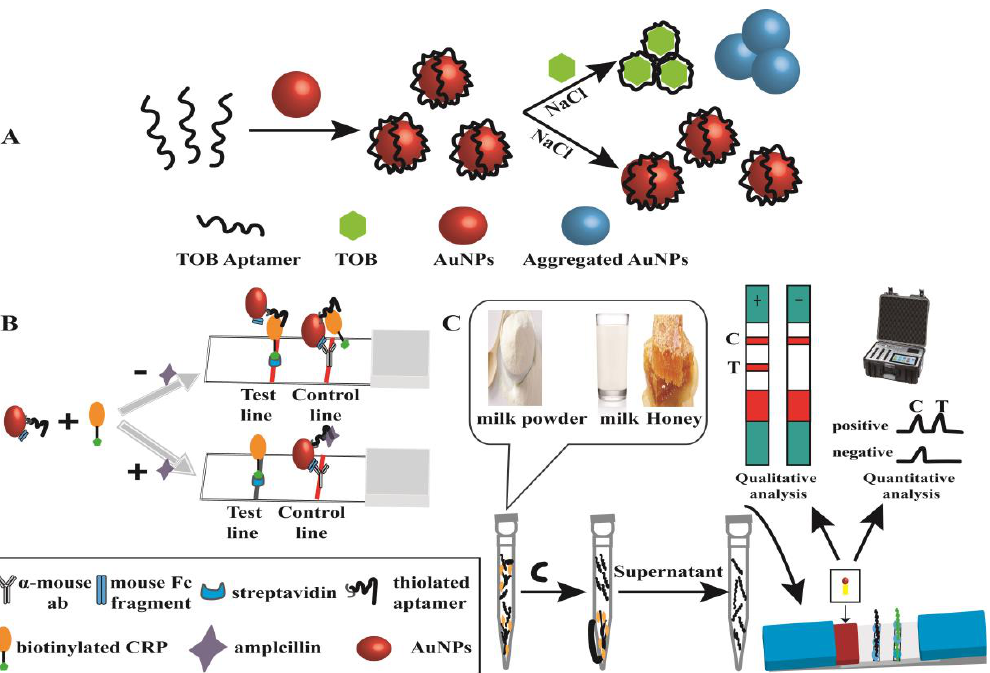
Figure 7. Nanomaterial-based colorimetric methods for antibiotic analysis. ( A ) The determination of tobramycin based on unmodified AuNPs, a single-strand DNA (ssDNA) probe, and AuNPs [53]. ( B ) Visual detection of ampicillin based on the combined of aptamer-based LFA and AuNPs [54]. ( C ) A fast and on-site detection of kanamycin, based on LFA with kanamycin-aptamer-modified AuNPs [55].